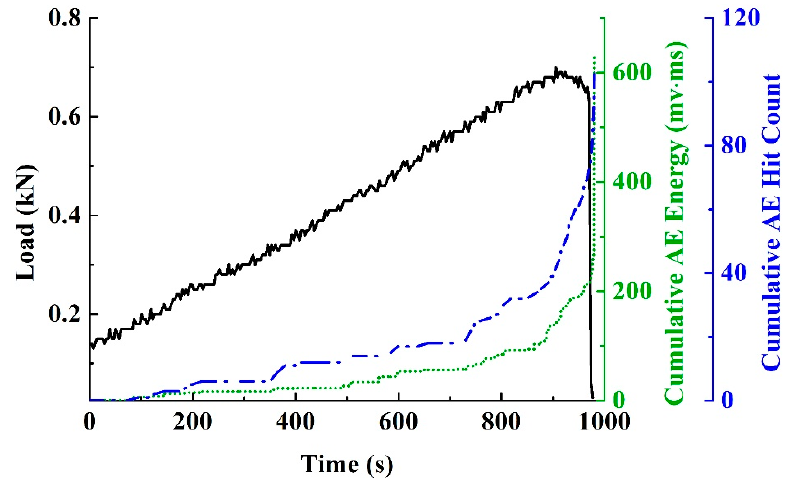
Figure 11. The cumulative acoustic emission (AE) energy and cumulative AE hit count of the water-saturated sample (W-2).